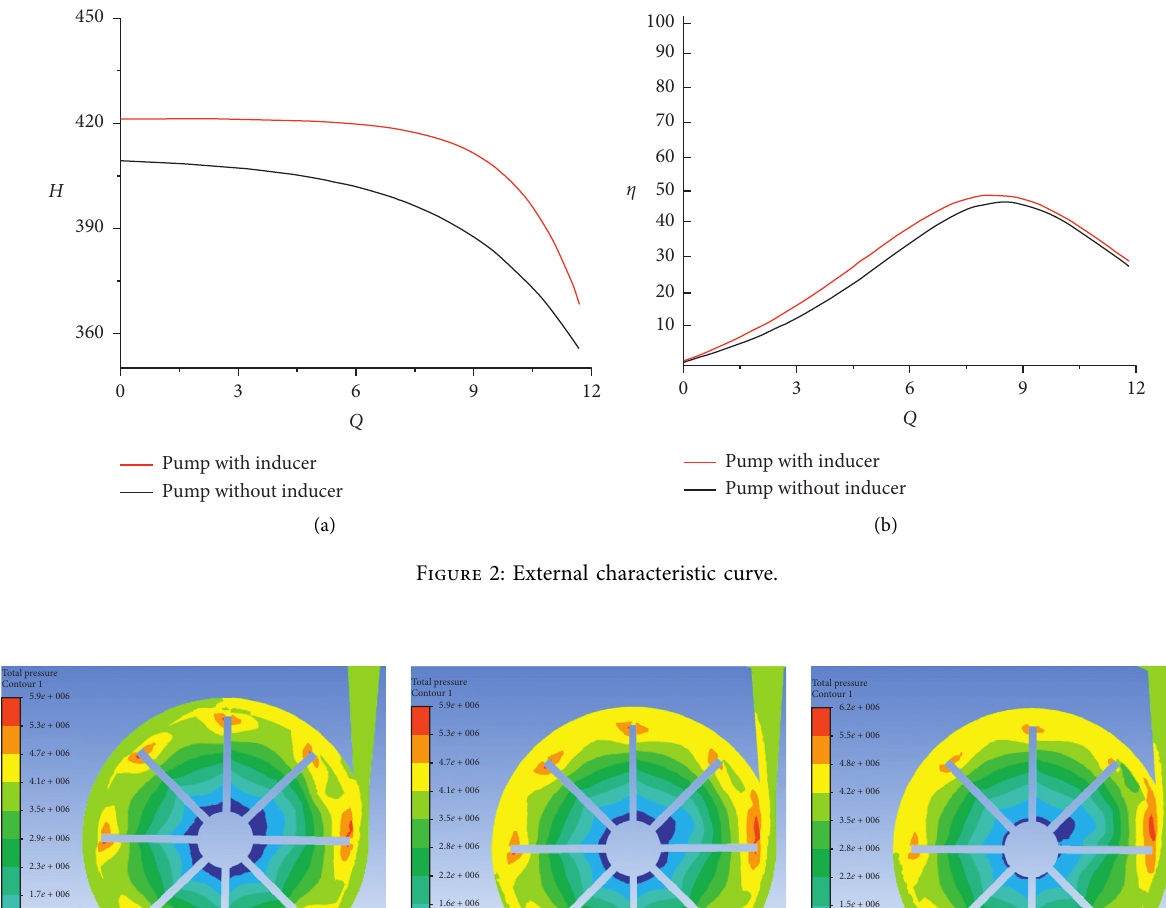
Figure 3: The total pressure distribution without inducer. (a) Q